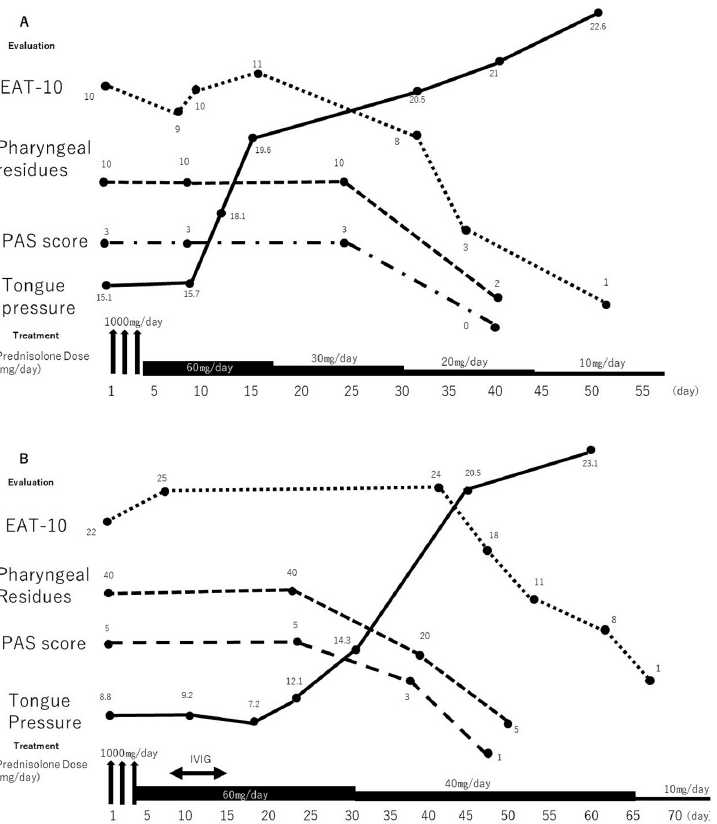
Figure 2. Timeline of the clinical course of the patients. ( A ) Changes in the results of swallowing evaluations and treatment provided in case 1 are shown. Tongue pressure improved slightly with prednisolone therapy. Subsequently, improvements were noted on VF and subjective evaluation.